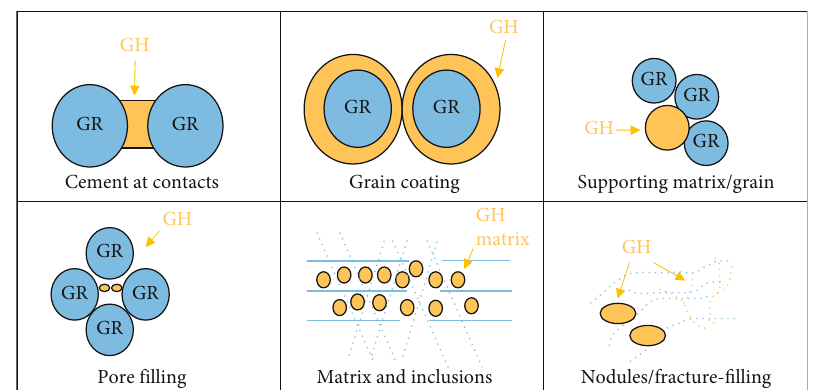
Figure 1: Occurrence status of hydrate in the Shenhu area [14].